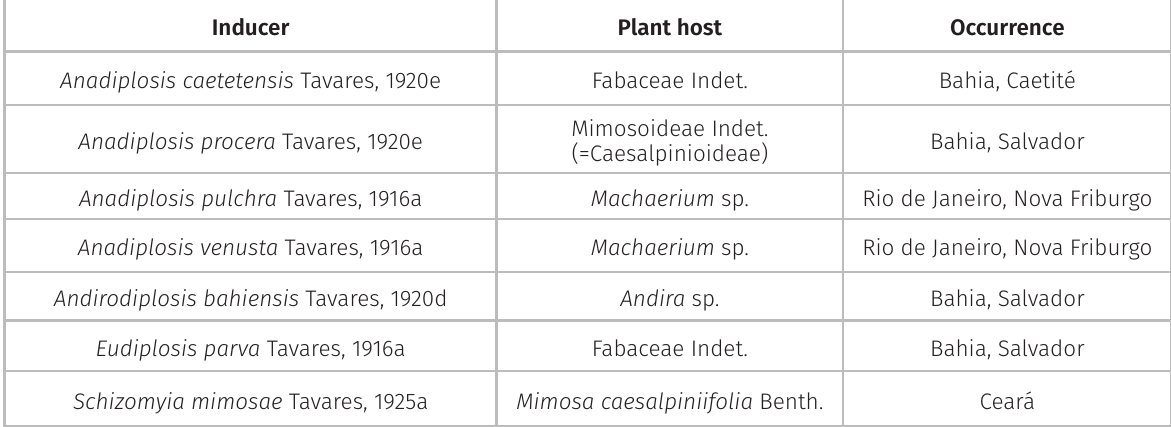
Table II. The first records of gall-inducing insects associated with Fabaceae undertaken by the naturalist J.S. Tavares between 1905 and 1925 (Gagné & Jaschhof